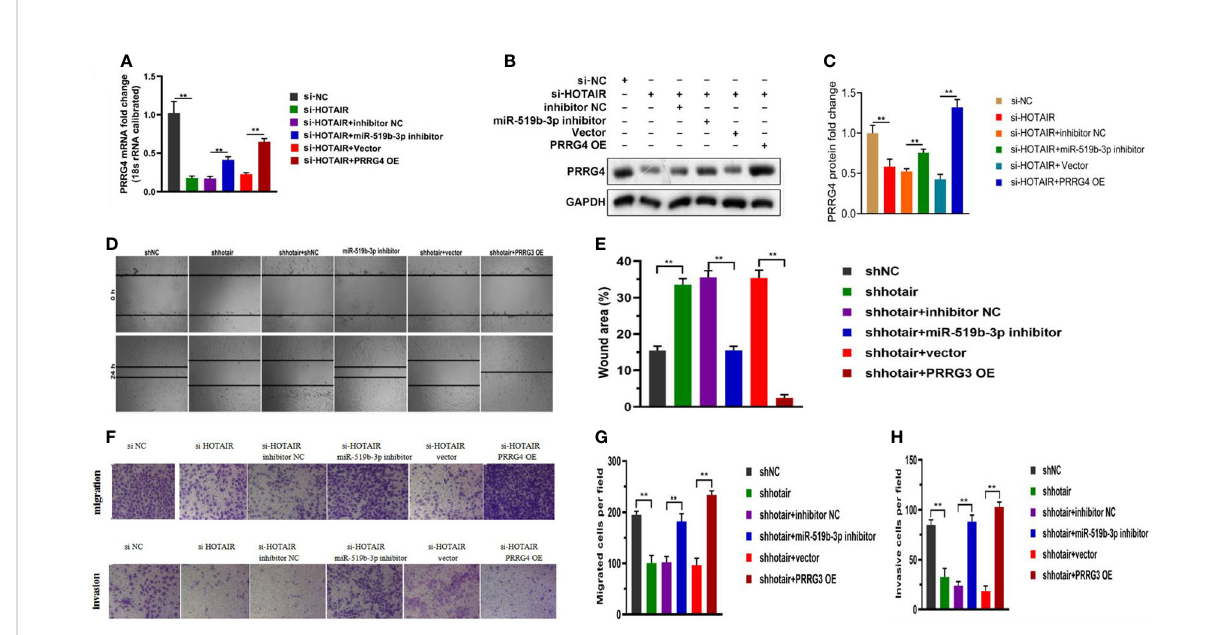
FIGURE 5 LncRNA HOTAIR combined with miR-519b-3p to regulate PRRG4 expression and migration and invasion ability of endometrial stromal cells. (A-C) Endometrial stromal cells were transfected with si-NC, si-HOTAIR, si-HOTAIR+inhibitor NC, si-HOTAIR+miR-519b-3p inhibitor, si- HOTAIR+Vector, and si-HOTAIR+PRRG4 OE. mRNA and protein levels of RPRG4 were examined by qRT-PCR and WB. (D-H) Scratch and transwell assays were used to detect the migration and invasion ability of endometrial stromal cells in different groups. Data are presented as the mean ± SEM, n=8 in each group. **P<0.01 vs. si-NC or